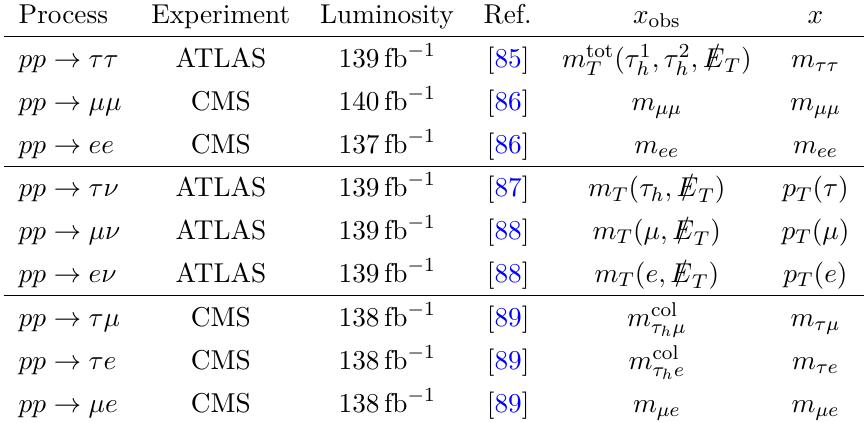
Table 3. Experimental searches by the ATLAS and CMS collaborations that have been recast in the HighPT package [48]. The last two columns refer to the measured and particle-level observables considered in our analyses. The data used in the present work corresponds to x all